Question: Provide a one-line summary of what is displayed.
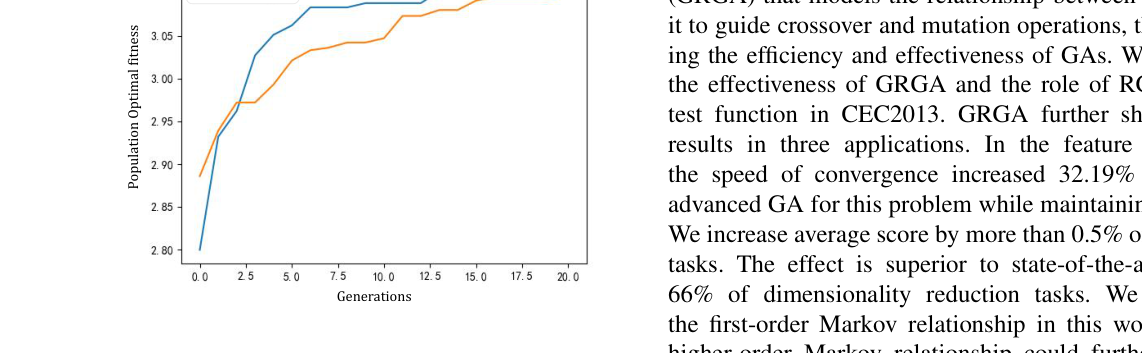
Answer: Result of accuracy changing with generations.